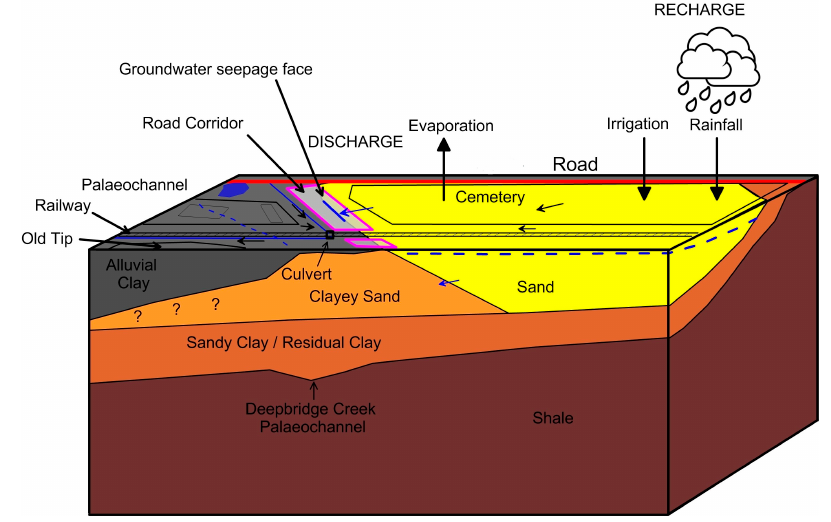
Figure 2. Conceptual model for the affected area aquifer.